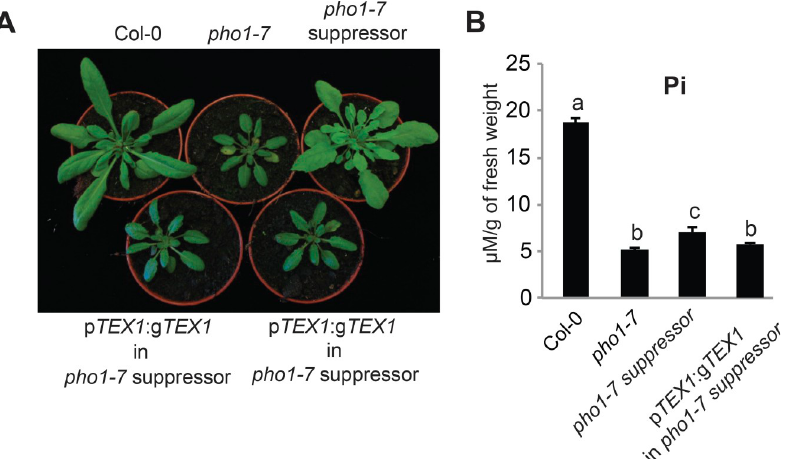
Fig 1. The tex1 mutation suppresses the shoot growth phenotype of the pho1-7 mutant. (A) Phenotype of Col-0, pho1-7 , pho1-7 suppressor , and pho1-7 suppressor transformed with the p TEX1 : gTEX1 : GFP .(B) Pi contents of 4-week- old rosettes. Data from a representative experiment shows the mean Pi content from ten different plants grown in independent pots. Errors bars represent standard deviation. Values marked with lowercase letters are statistically significantly different from those for other groups marked with different letters (P < 0.05, ANOVA with the Tukey- Kramer HSD test). Panel display a representative